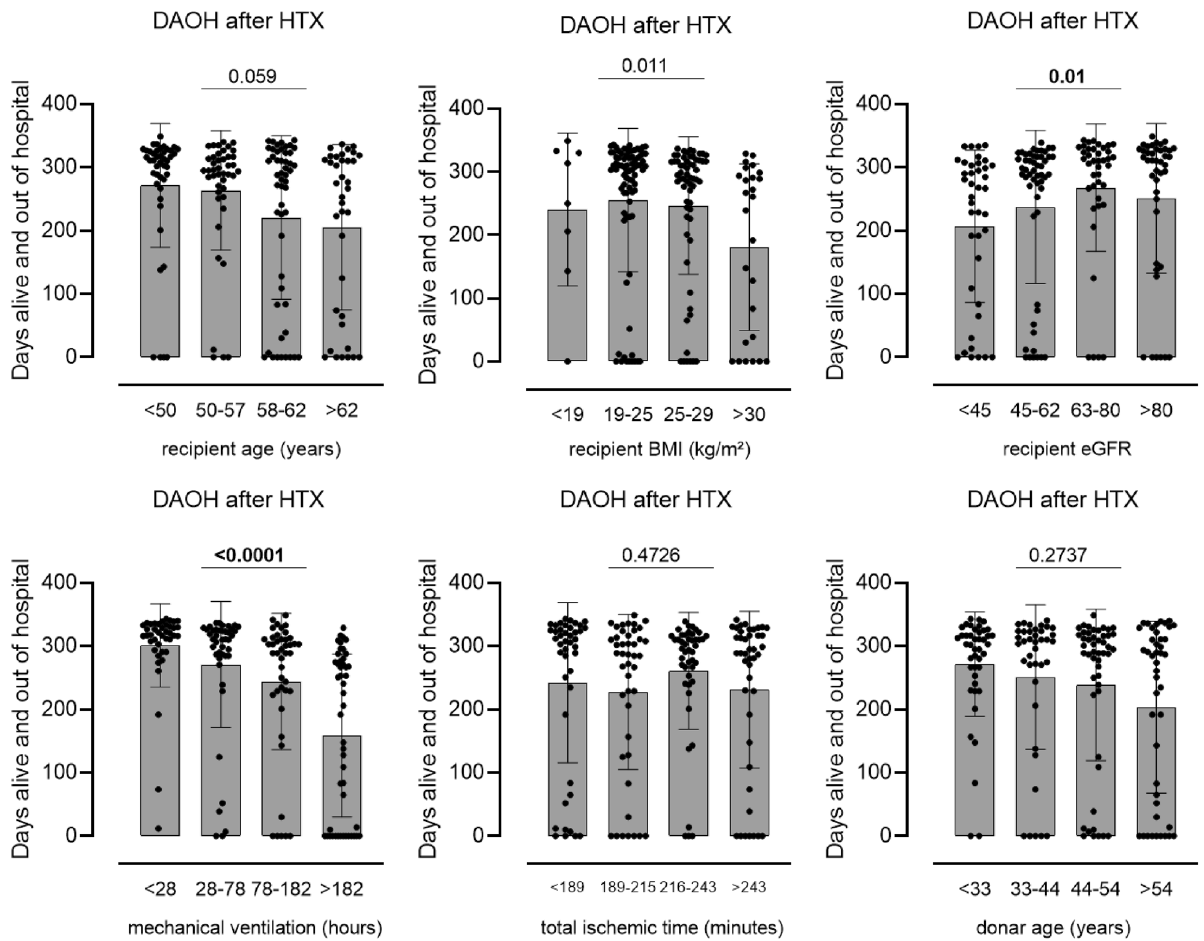
Figure 2. Influence of continuous variables on DAOH. Univariate analysis for the association of 6 continuous variables with days alive and out of hospital (DAOH) at 1 year after heart transplantation (HTX). To visualize distribution of DAOH, all continuous variables were stratified by